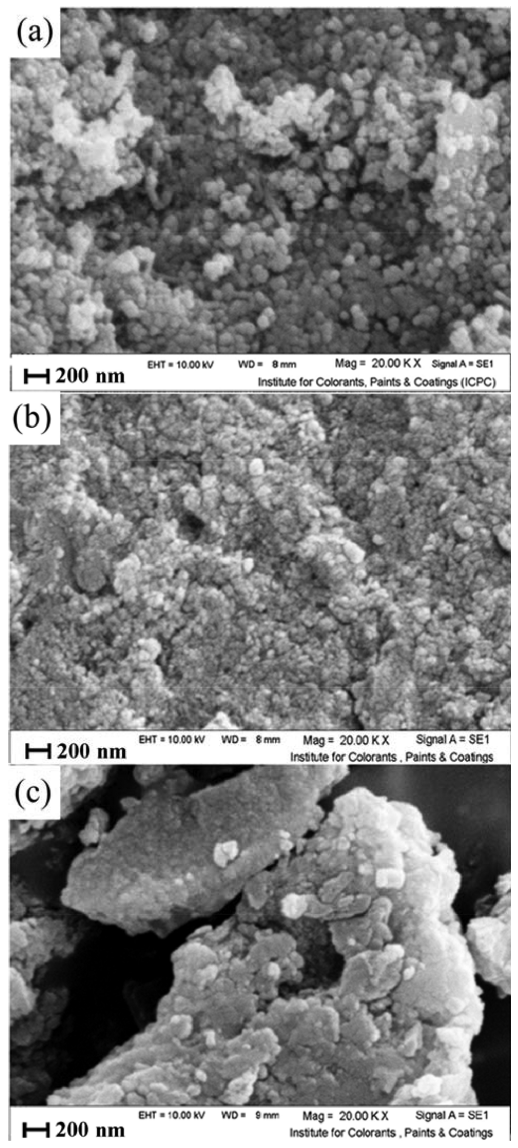
Figure 3: SEM images of MnOOH synthesized by using (a) water (sample no. 1), (b) ethanol (sample no. 2) and (c) methanol (sample no. 3) as